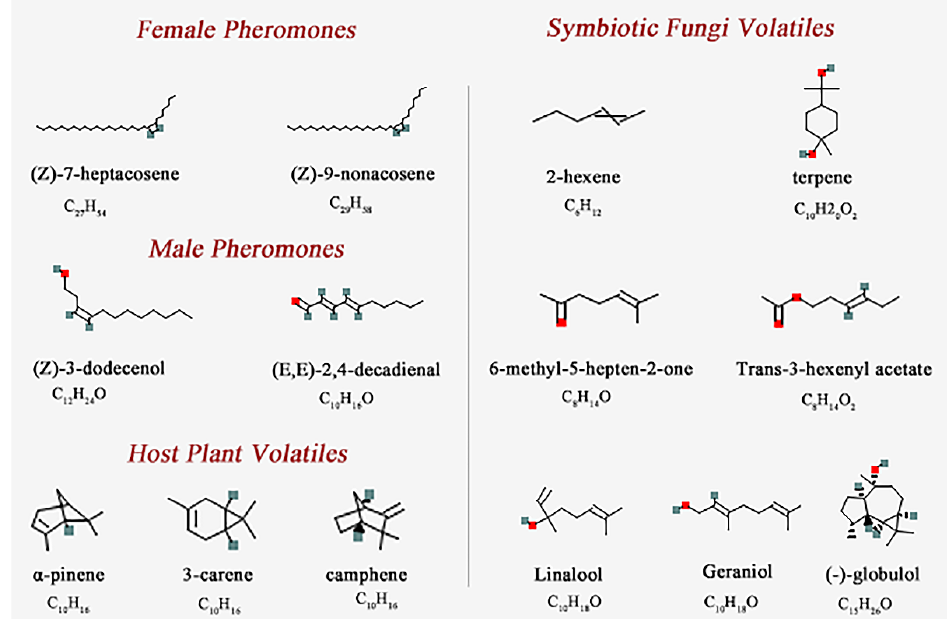
Figure 1. The 2D structures of 14